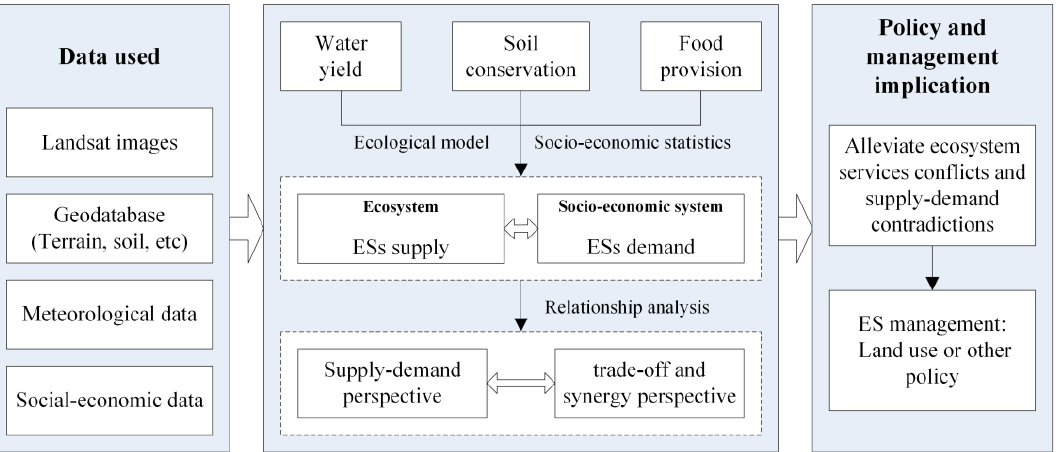
Figure 2. The overall research framework of this study.